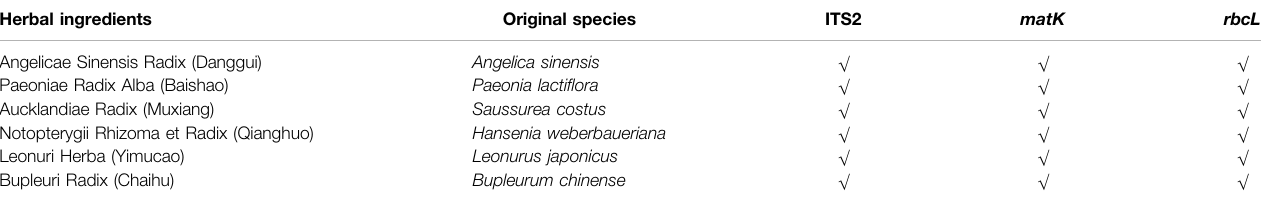
TABLE 4 | Species detection of the ITS2, matK , and rbcL DNA barcoding regions obtained via shotgun metabarcoding in the lab-made mock FKDSW sample. Herbal